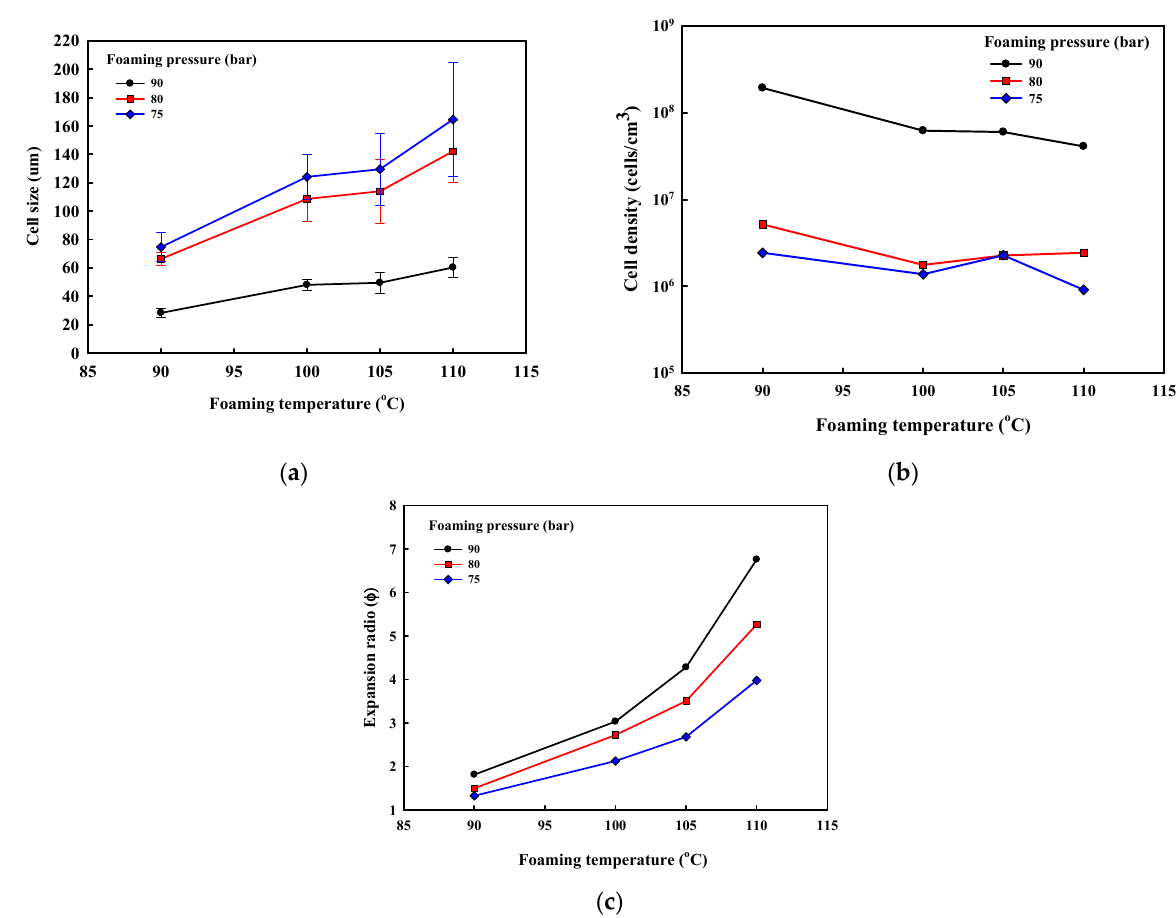
Figure 3. Physical properties of ETPU beads prepared at different foaming temperatures and pressures in the supercritical CO 2 foaming process: ( a ) foam size; ( b ) foam density; ( c ) expansion ratio.